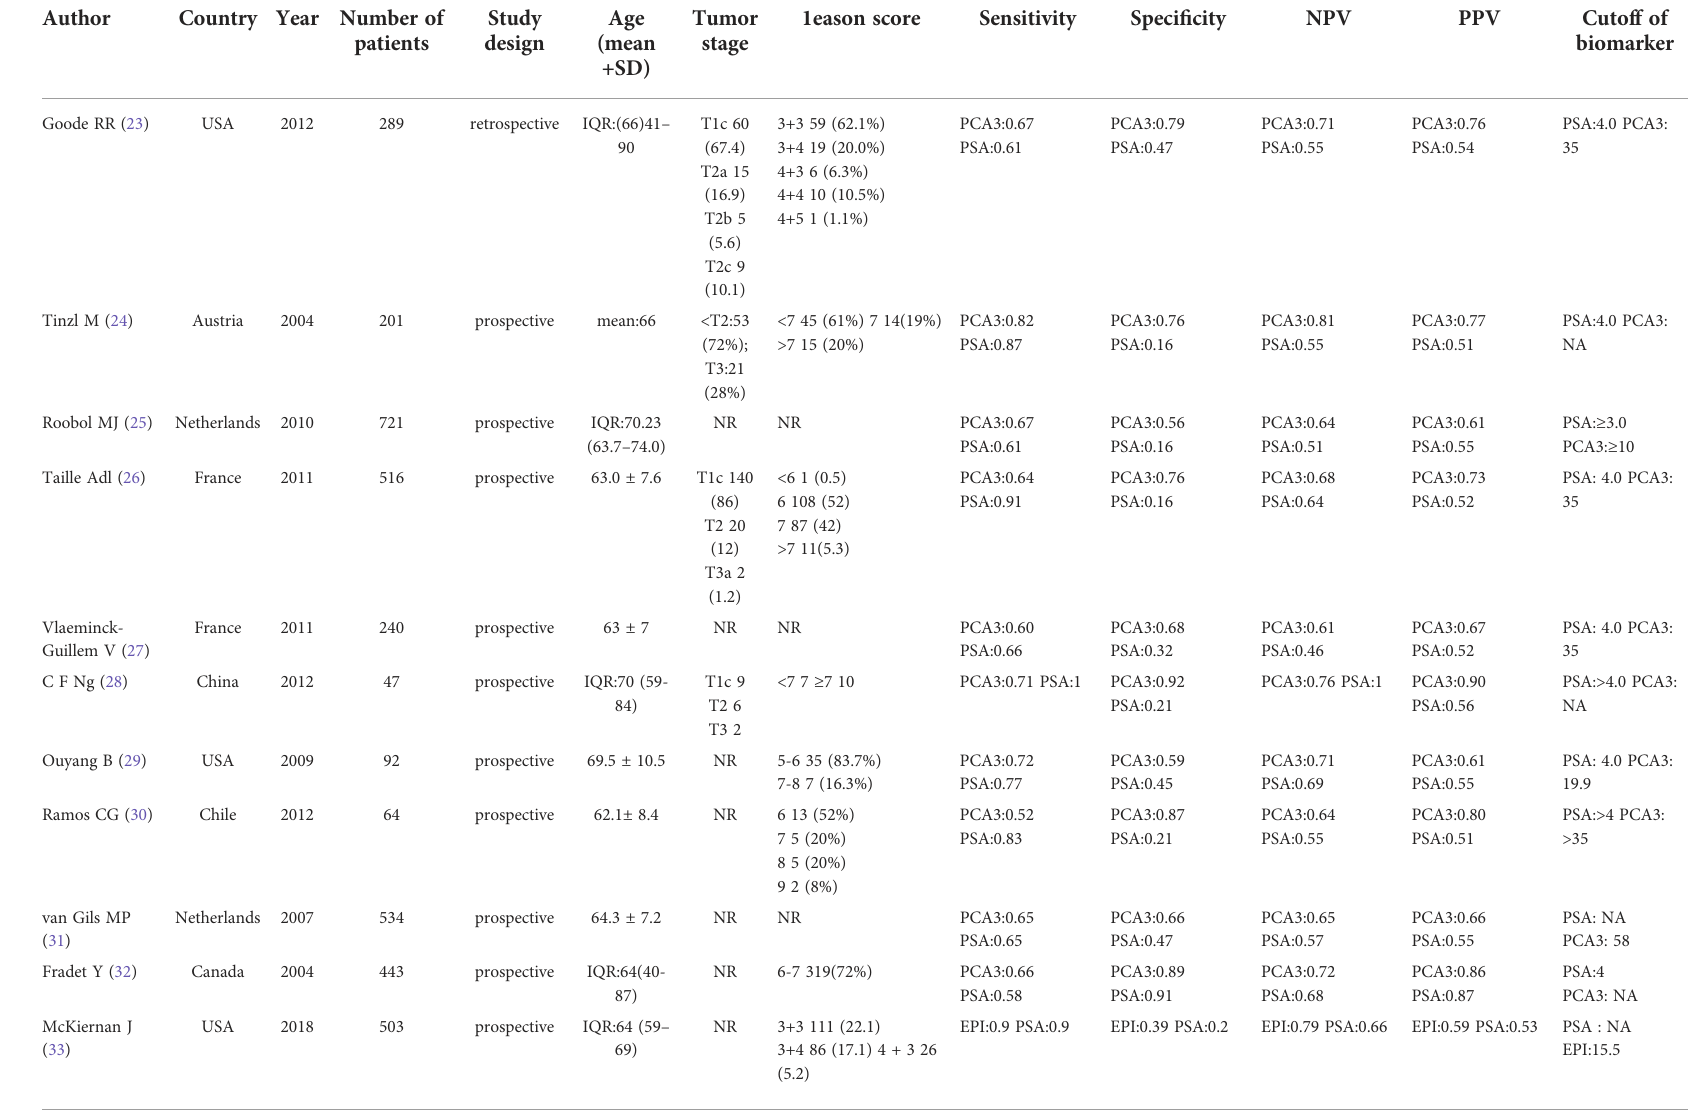
TABLE 1 Characteristics of the studies included in the